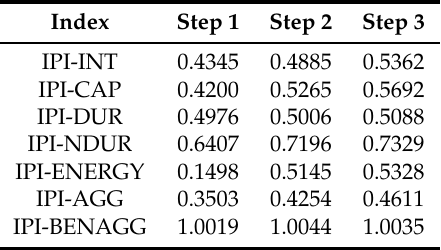
Table 18. Comparison of the ratios of mean absolute error with an expanding window from 2008:01 to